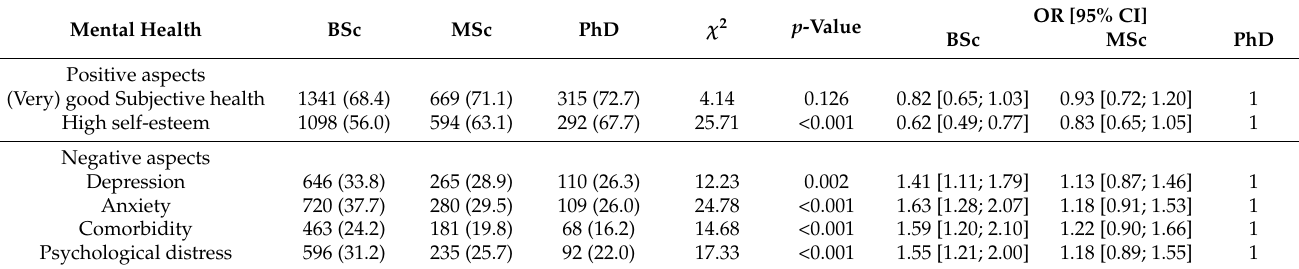
Table 3. Student mental health by academic level for categorical